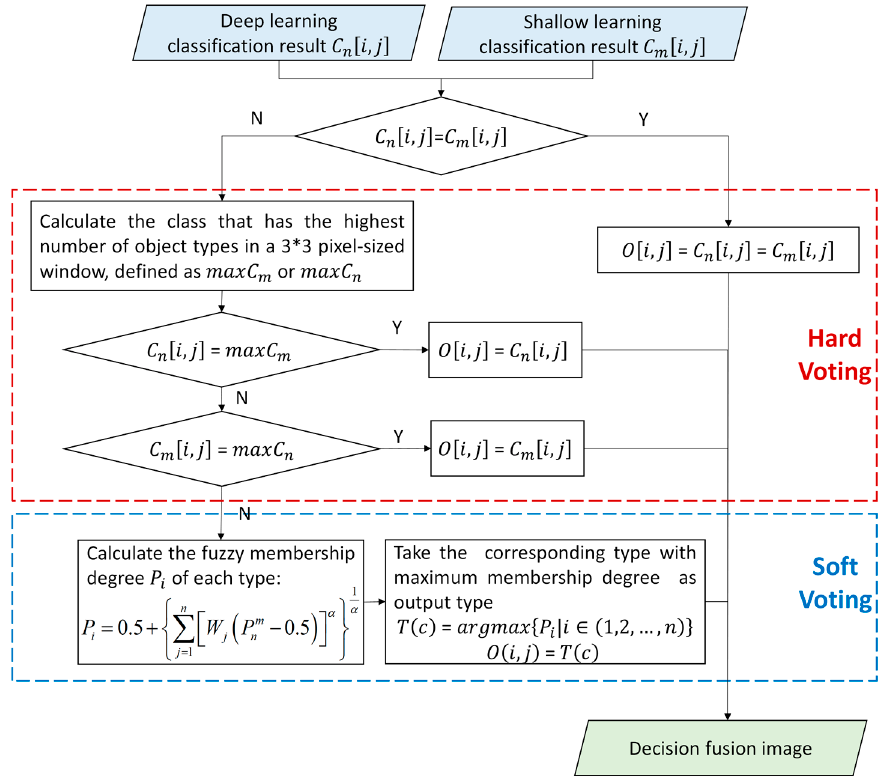
Figure 4. Flowchart of the deep and shallow learning decision fusion. N and Y represent no and yes, respectively. The flowchart includes hard voting and soft voting.